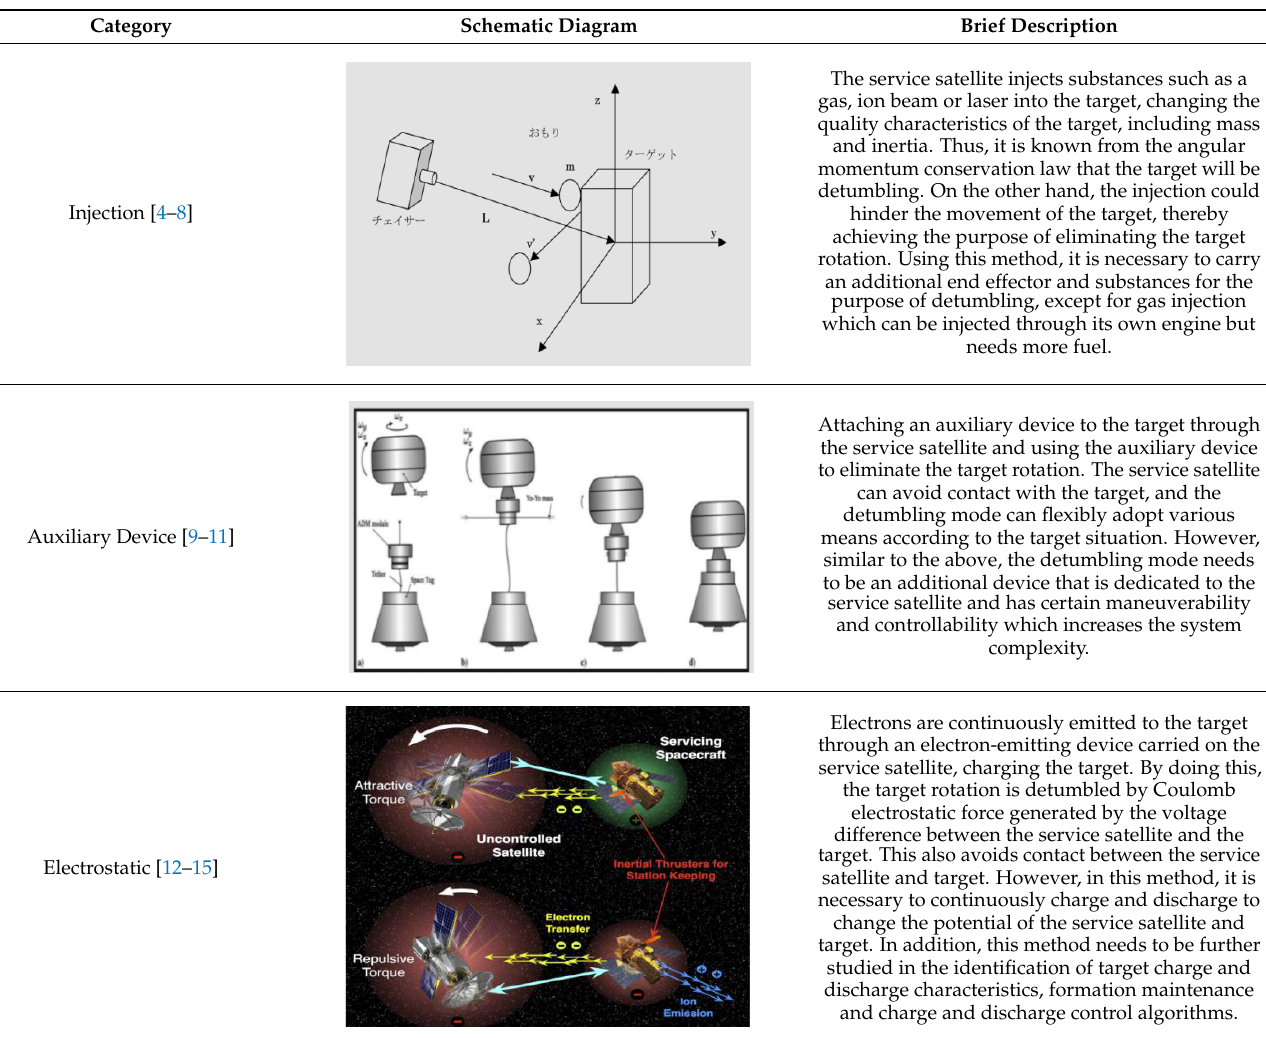
Table 1. Summary of the detumbling methods in recent